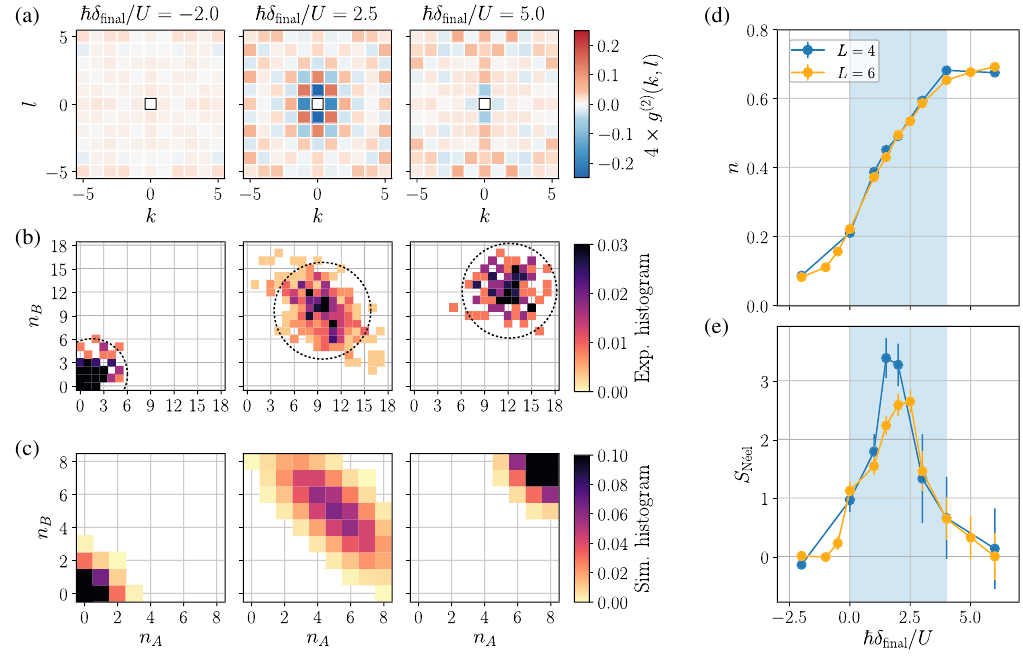
FIG. 2. Exploring the Ω ¼ 0 line of the phase diagram for an L × L square lattice with L ¼ 4 and L ¼ 6 . (a) Experimental spin-spin correlation function g ð 2 Þ ð k; l Þ for different values of the final detuning. (b) Corresponding experimental histograms of the populations of the two N´eel sublattices A and B , to be contrasted with those for uncorrelated random states with the same Rydberg density (the dotted circles indicate the positions where the random state histogram falls off to a value of 5 × 10 − 4 ). (c) Simulated histograms (without dephasing) for L ¼ 4 as a comparison. (d) Average Rydberg density n , and (e) N´eel structure factor S detuning. The shaded areas highlight the region of the AF phase in the phase diagram for Ω ¼ 0 . In (d) and (e), the error bars (sometimes smaller than the symbol size) denote the standard error on the mean